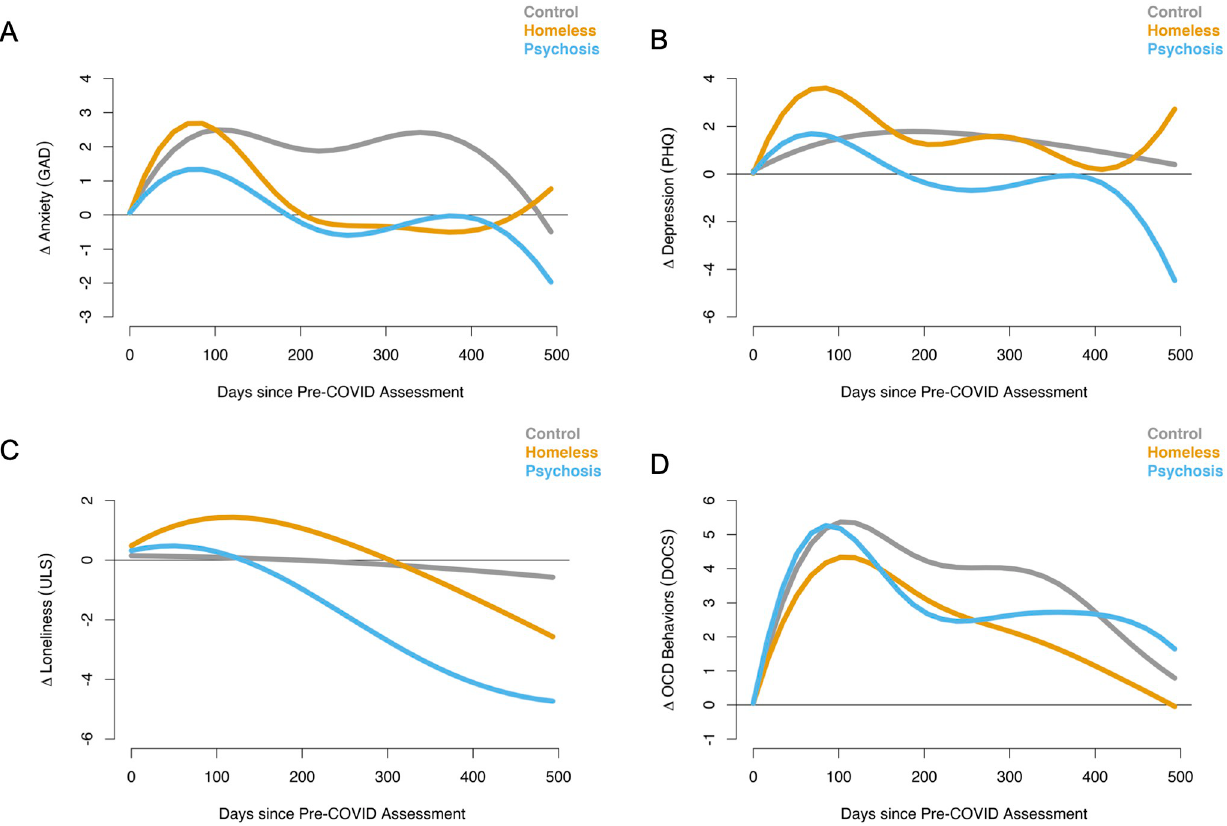
Fig 1. Results for the GAM analyses of clincial outcomes. The smoothed curves represent the change over time in trajectories for controls (CTL; gray), recently housed Veterans (RHV; yellow), and Veterans with psychosis (PSY; blue). In all cases higher scores indicate higher symptoms. The panels show results for A) anxiety, B) depression, C) loneliness, and D) obsessive-compulsive traits.